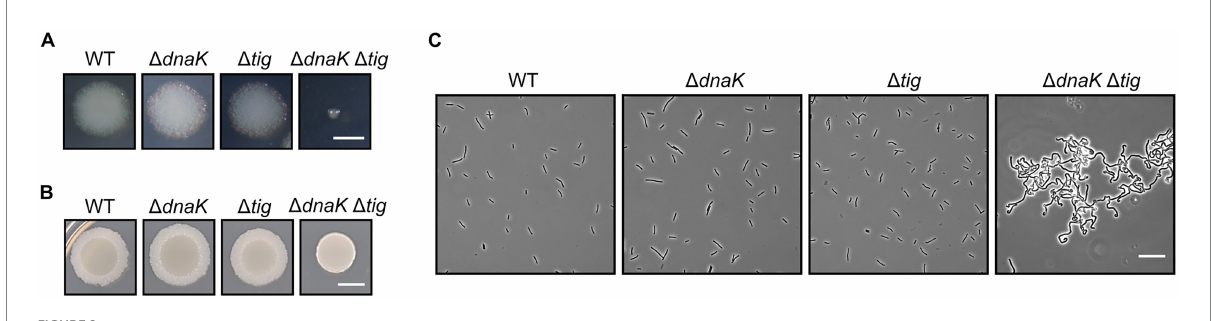
FIGURE 2 Colony size and cell morphology of chaperone deletion mutants. (A) Depiction of single colonies of B. subtilis wild-type (1A1), Δ dnaK (LUW876), Δ tig (LUW901), and Δ dnaK Δ tig (LUW878) from overnight TBAB plates incubated at 30 ° C. The scale bar represents 1 mm. (B) Shown are TBAB plates inoculated with 5- μ l drops of the four indicated strains and incubated at 30 ° C. Cells for the drop inoculum were taken from LB cultures at mid-exponential growth phase. The scale bar represents 0.5 cm. (C) Representative phase contrast micrographs of the four indicated strains. Cells were taken from single colonies from overnight TBAB plates incubated at 30 ° C. The scale bar represents 20 μ m.